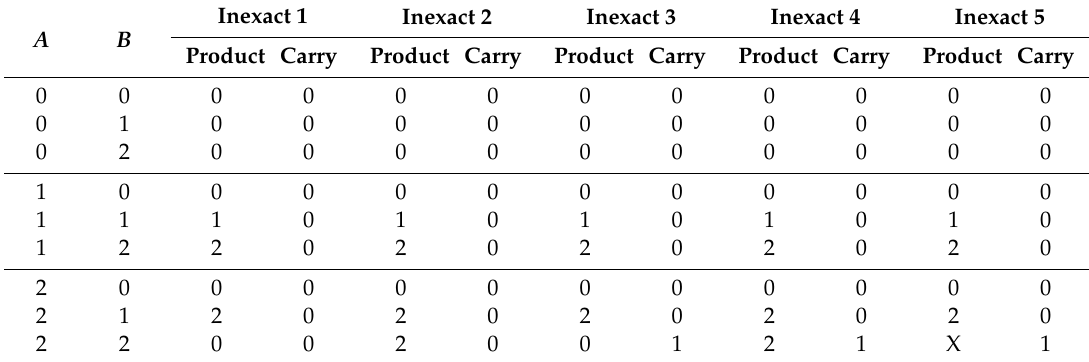
Table 3. Truth Table of inexact ternary multipliers.